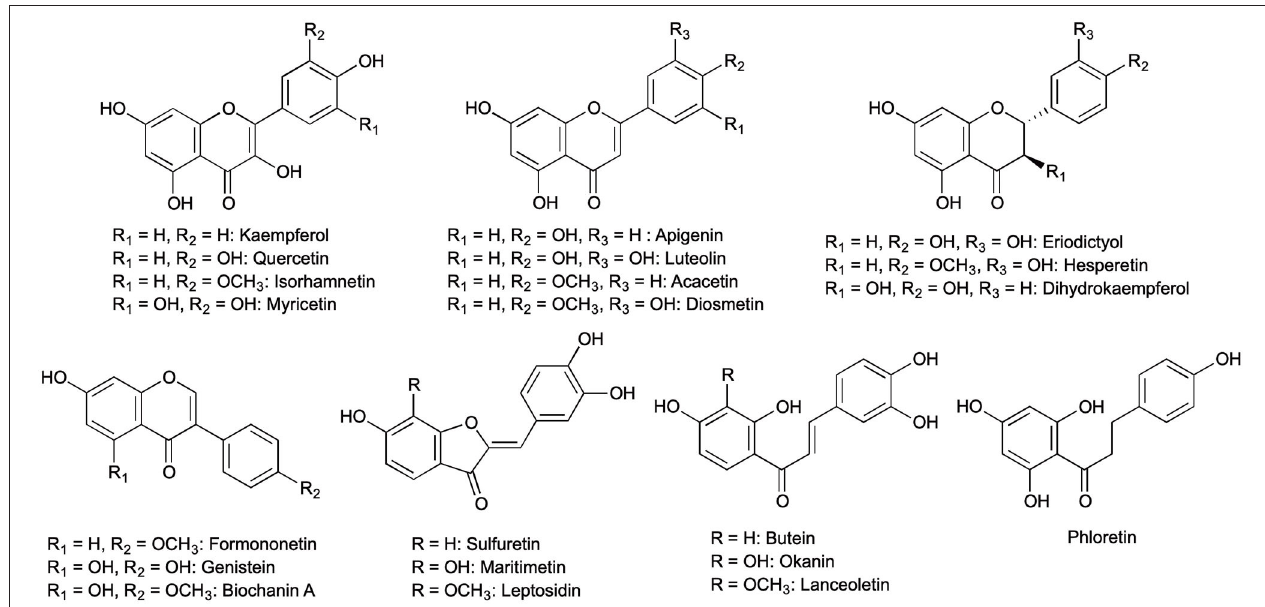
FIGURE 1 | All 21 flavonoid aglycones found in methanolic extracts of Bidens ferulifolia , Coreopsis grandiflora , Fagus sylvatica , Malus × domestica , Mentha × piperita , Petunia × hybrida , Quercus robur , Robinia pseudoacacia, and Trifolium pratense